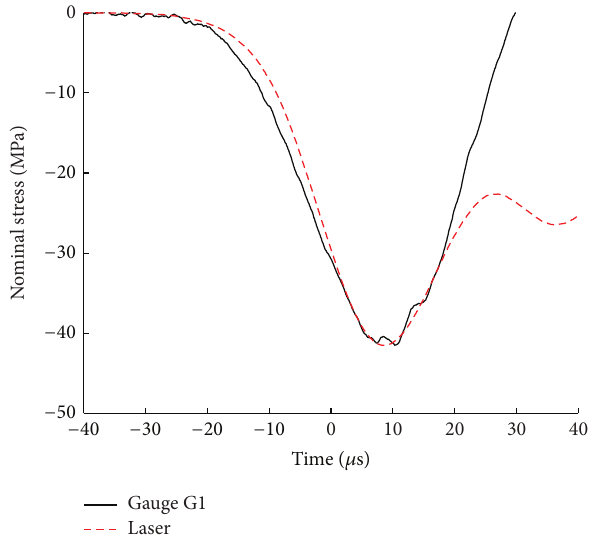
Figure 3: Nominal stress obtained from gauge G1 ( 𝐸𝜀 ) and based on rear face velocity ( (1/2)𝜌𝐶 0 𝑉 ) in a specimen without preexisting